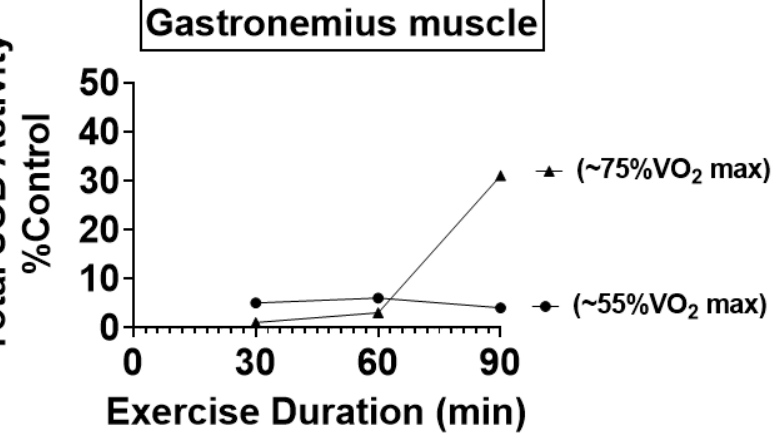
Figure 3. Illustration of the exercise dose–response increases in total SOD activity (SOD + SOD2) in the rat soleus muscle following 10 weeks of endurance exercise training. Data are from reference [51] .